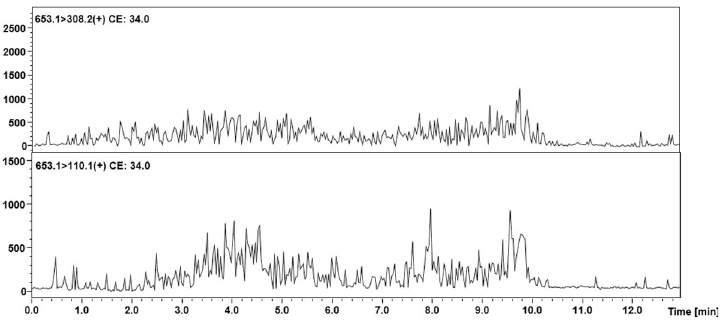
Fig 2. MRM analysis of the urine sediment tryptic digest sample which does not contain podocin. The peaks characteristic for the transitions of the analyzed tryptic podocin peptide were not